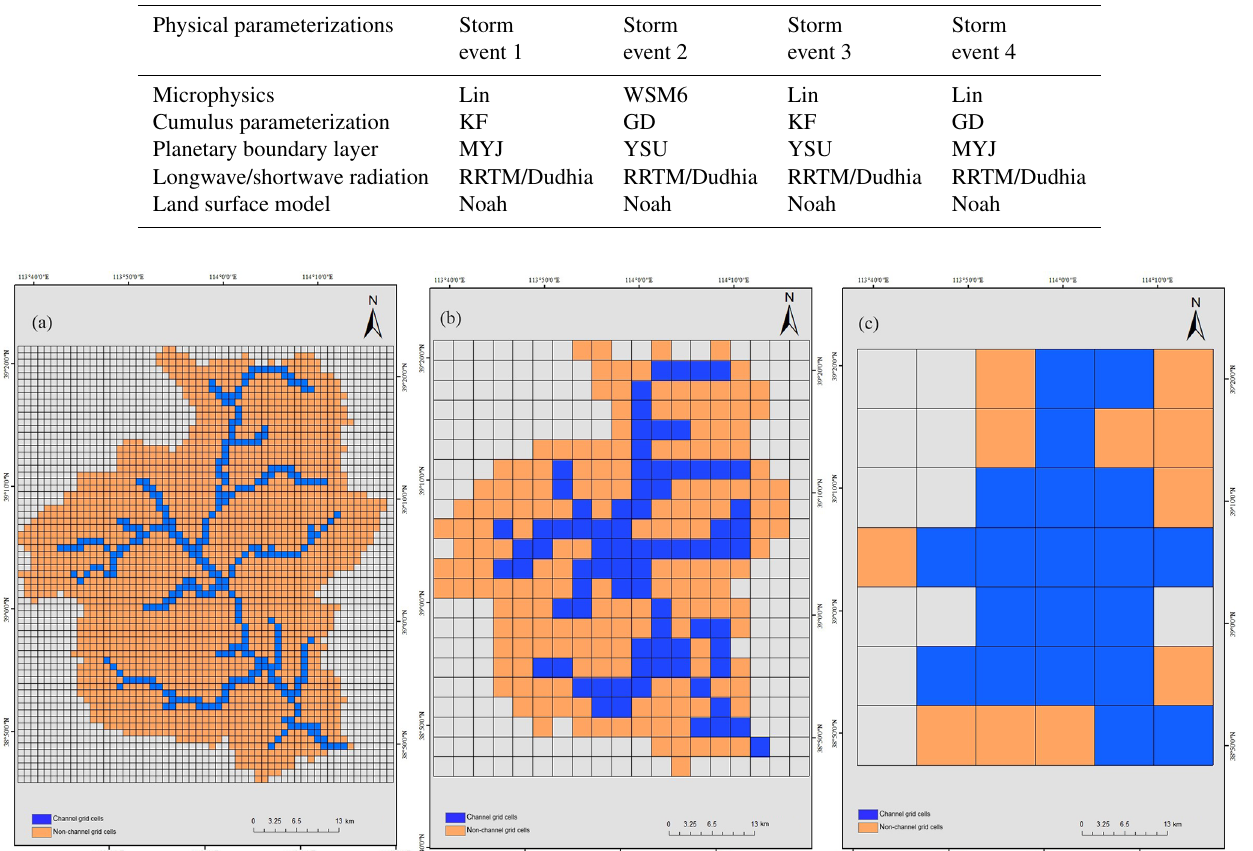
Figure 5. DEM grids for the Fuping sub-watershed with channel and non-channel cells: (a) 1km × 1km grids, (b) 3km × 3km grids, and (c) 9km × 9km